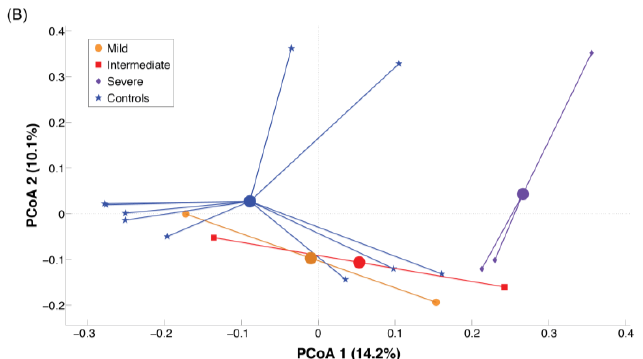
Figure 2. Principal Coordinate Analysis (PCoA) according to unweighted Unifrac distance. The first two components of the variance are represented. ( A ) PCoA of Rett (red) versus control (blue) samples. The two groups tend to separate according to PCoA 1 component. Differences are not statistically significant ( p > 0.05); ( B ) Samples are colored according to disease severity. Severe stage (purple) significantly ( p < 0.05) separates from healthy controls. Other differences are not statistically significant ( p > 0.05).